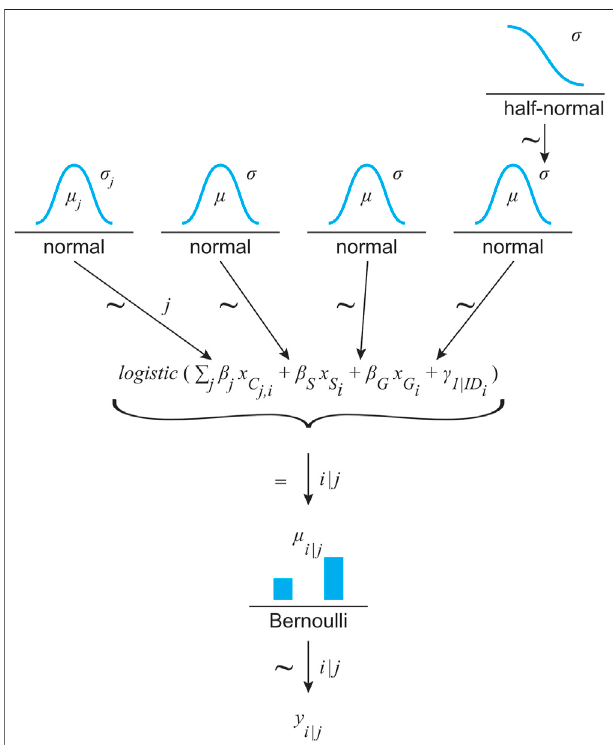
FIGURE 5 | Model structure for predicting each binary outcome of a possible crossing ( y i ) depending on the simulation environment ( j ) and based on a Bernoulli distribution. Its μ value results from a linear logistic function with condition (C, 6 categorical levels referenced by index ( j ), speed ( S ) and gap size ( G ) as fi xed effects. Due to the repeated measures design, the participants ’ ID was treated as a random effect ( c ). The estimators were